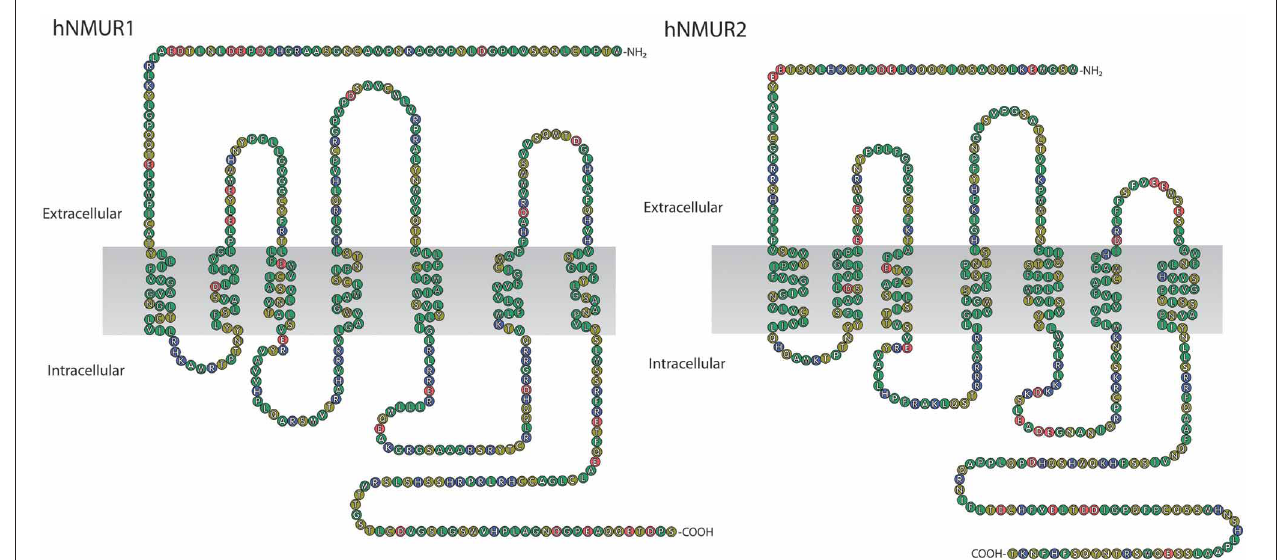
FIGURE 4 | Schematic representation of human NMUR1 and NMUR2 receptors. NMUR1 receptor is composed of 426 amino acid residues while NMUR2 of 415. Amino acid sequences were acquired from NCBI, accession numbers AAG24793.1 and EAW61653.1,